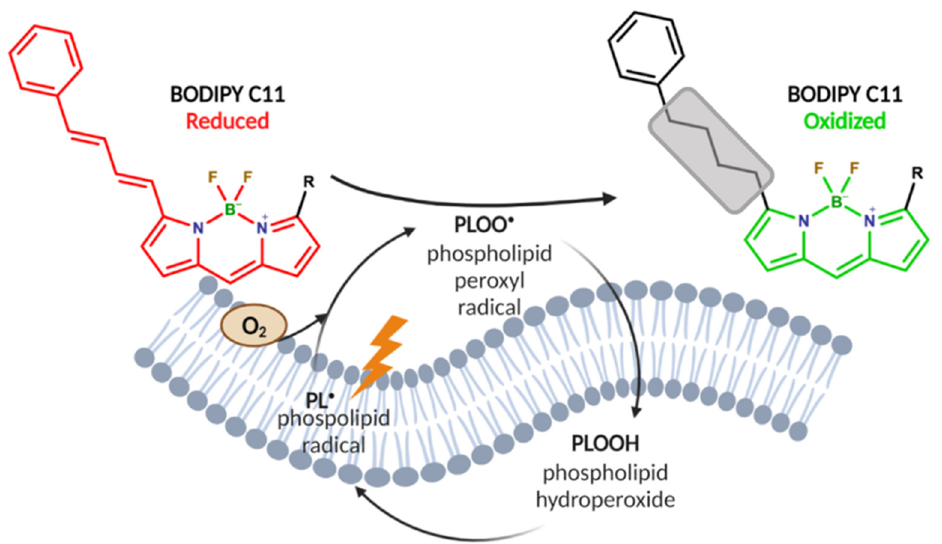
Figure 5. Mechanism of BODIPY oxidation by lipid radicals. LPO occurs when lipid radicals react with oxygen, cycling to phospholipid peroxyl radical and phospholipid hydroperoxide. This probe was designed to migrate to lipid cellular membranes, where R = 11 carbon chain, hence C11. In its reduced state, BODIPY emits fluorescence red light due to its conjugated diene phenyl structure. Upon oxidation, by phospholipid peroxyl radical, the diene chain loses conjugation, therefore preventing localization of electrons in this region. This shifts the fluorescent emission from red to green.